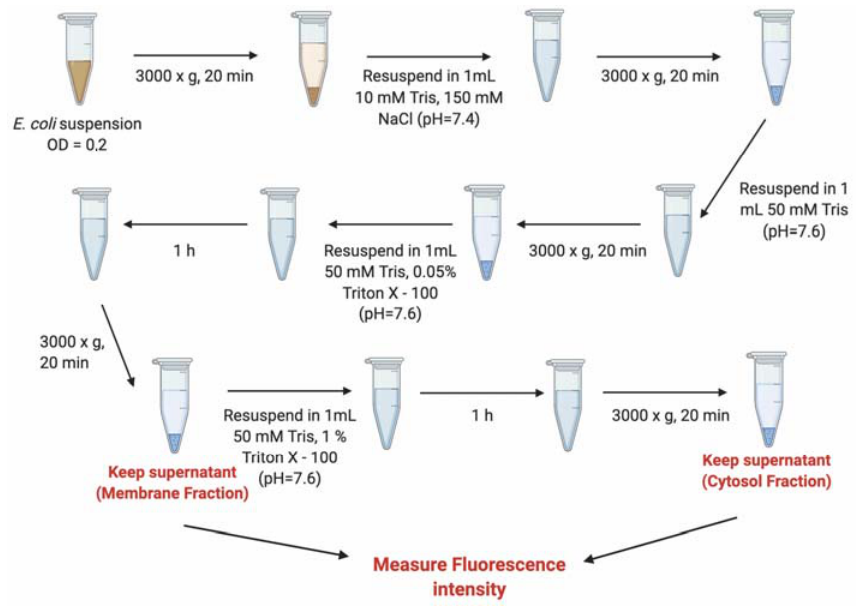
Figure 6. Fractionation protocol adapted from Bandula et al. [50]. A series of washing steps with a Triton X-100 gradient allows the isolation of the membrane and the cytosol fractions.